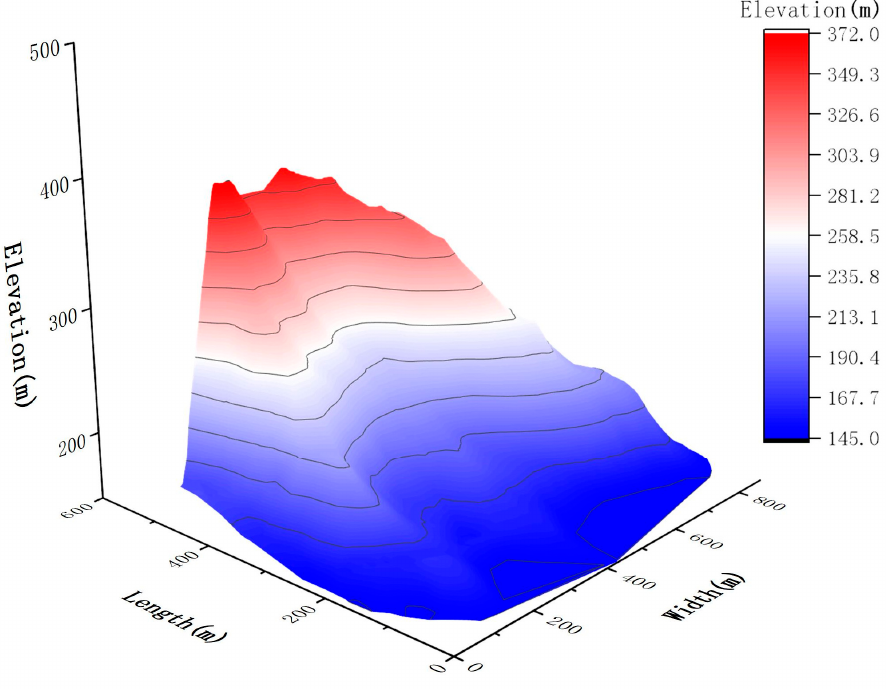
Figure 12. Three-dimensional morphology of the Baijiabao landslide.